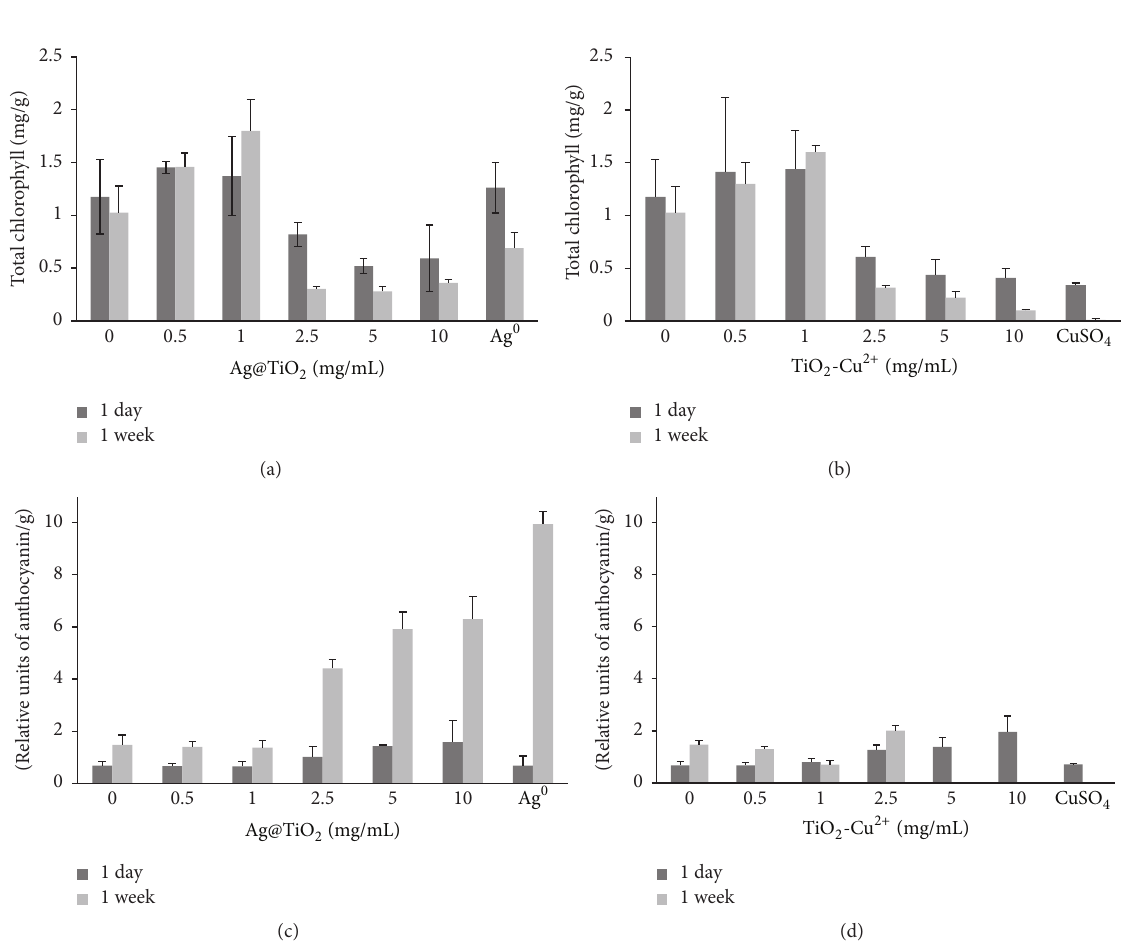
Figure 7: Total chlorophyll and anthocyanin content. Total chlorophyll content (mg/g of tissue) in seedling exposed to (a) Ag@TiO 2 and (b) TiO 2 -Cu 2+ ; anthocyanin content (relative units of anthocyanin (RUA)/g of tissue) in seedlings exposed to (c) Ag@TiO 2 and (d) TiO 2 -Cu 2+ ; columns represent the mean and the bars represent ± one standard deviation; 𝑛 = 3